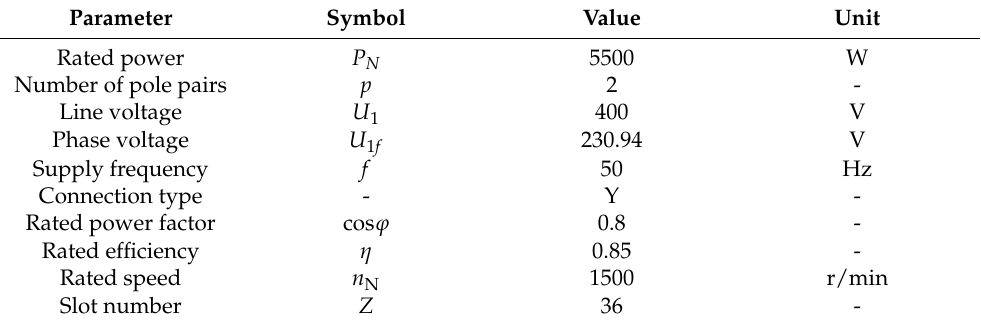
Table 1. Starting data for the stator design.